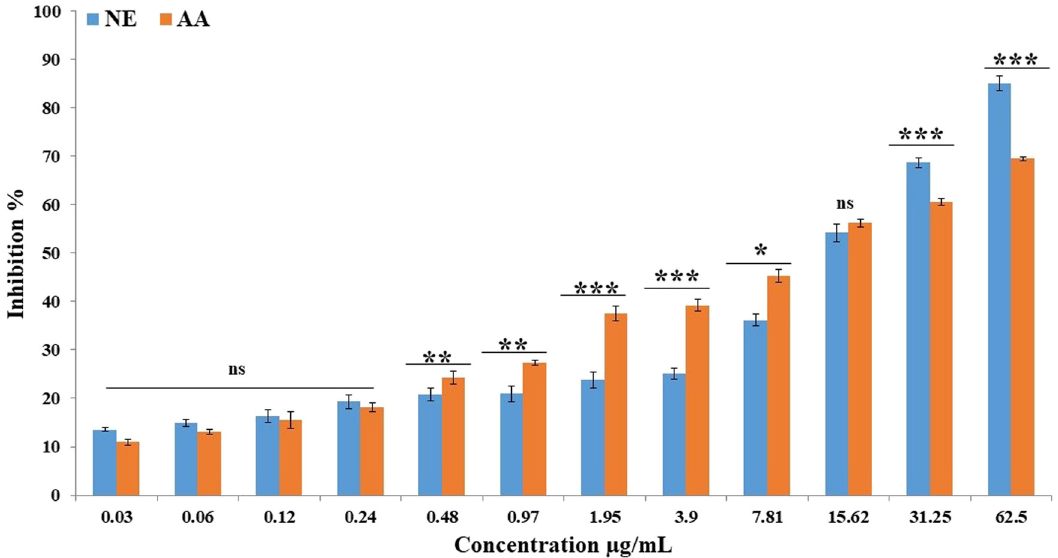
Figure 4: Inhibitory activity of clove bud EO nanoemulsion against DPPH free radicals. Data represents mean ± SD of triplicates. The